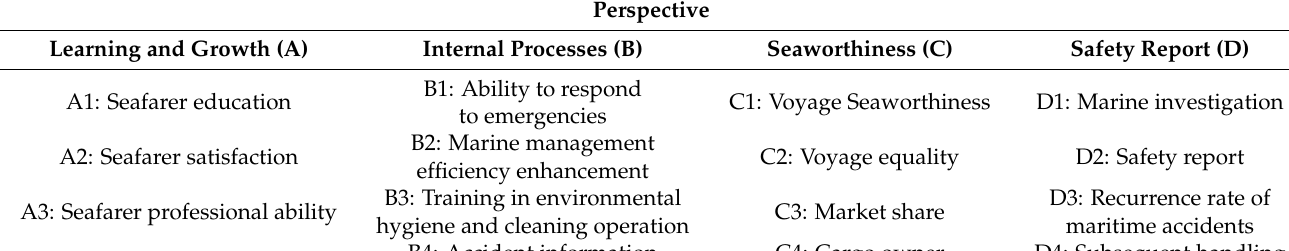
Table 1. Maritime accident assessment factors.